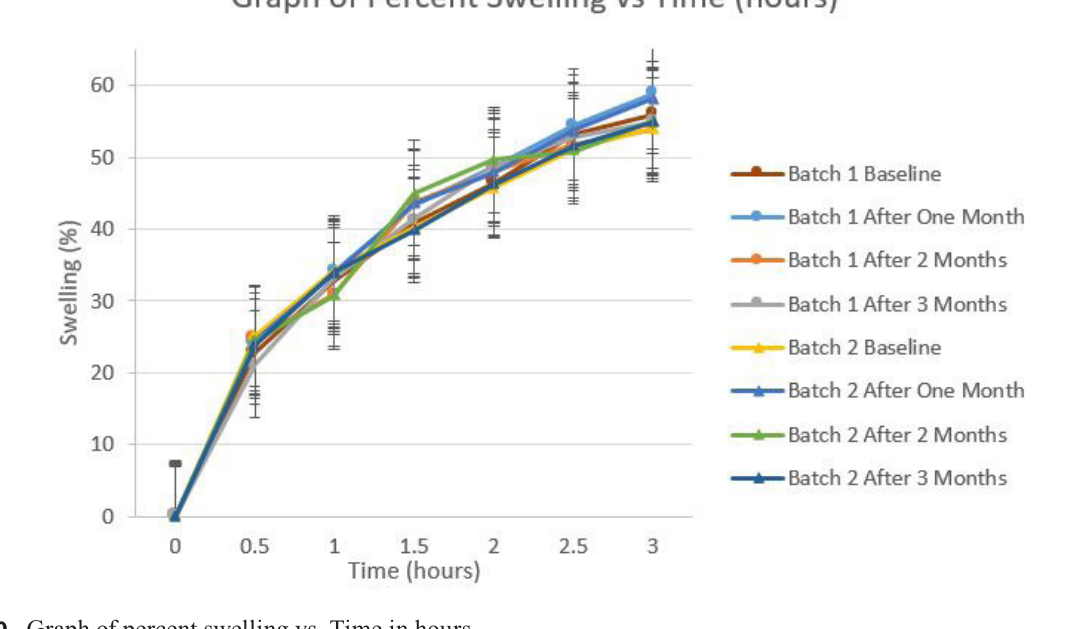
FIGURE 10 - Graph of percent swelling vs. Time in